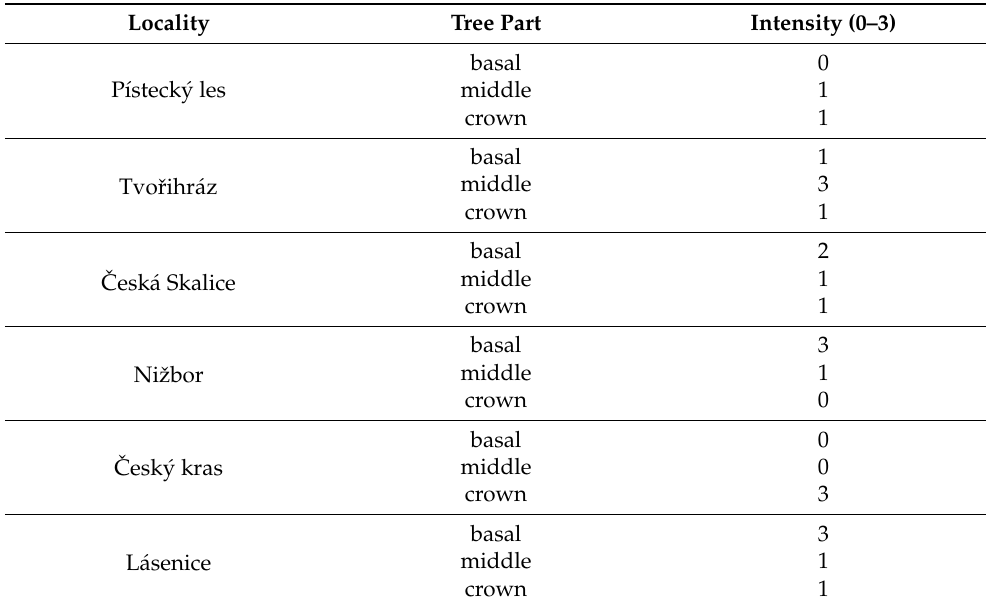
Table 2. Intensity of Ophiostoma spp. presence identified at individual forest stands (Locality) and in different tree parts. Locality Tree